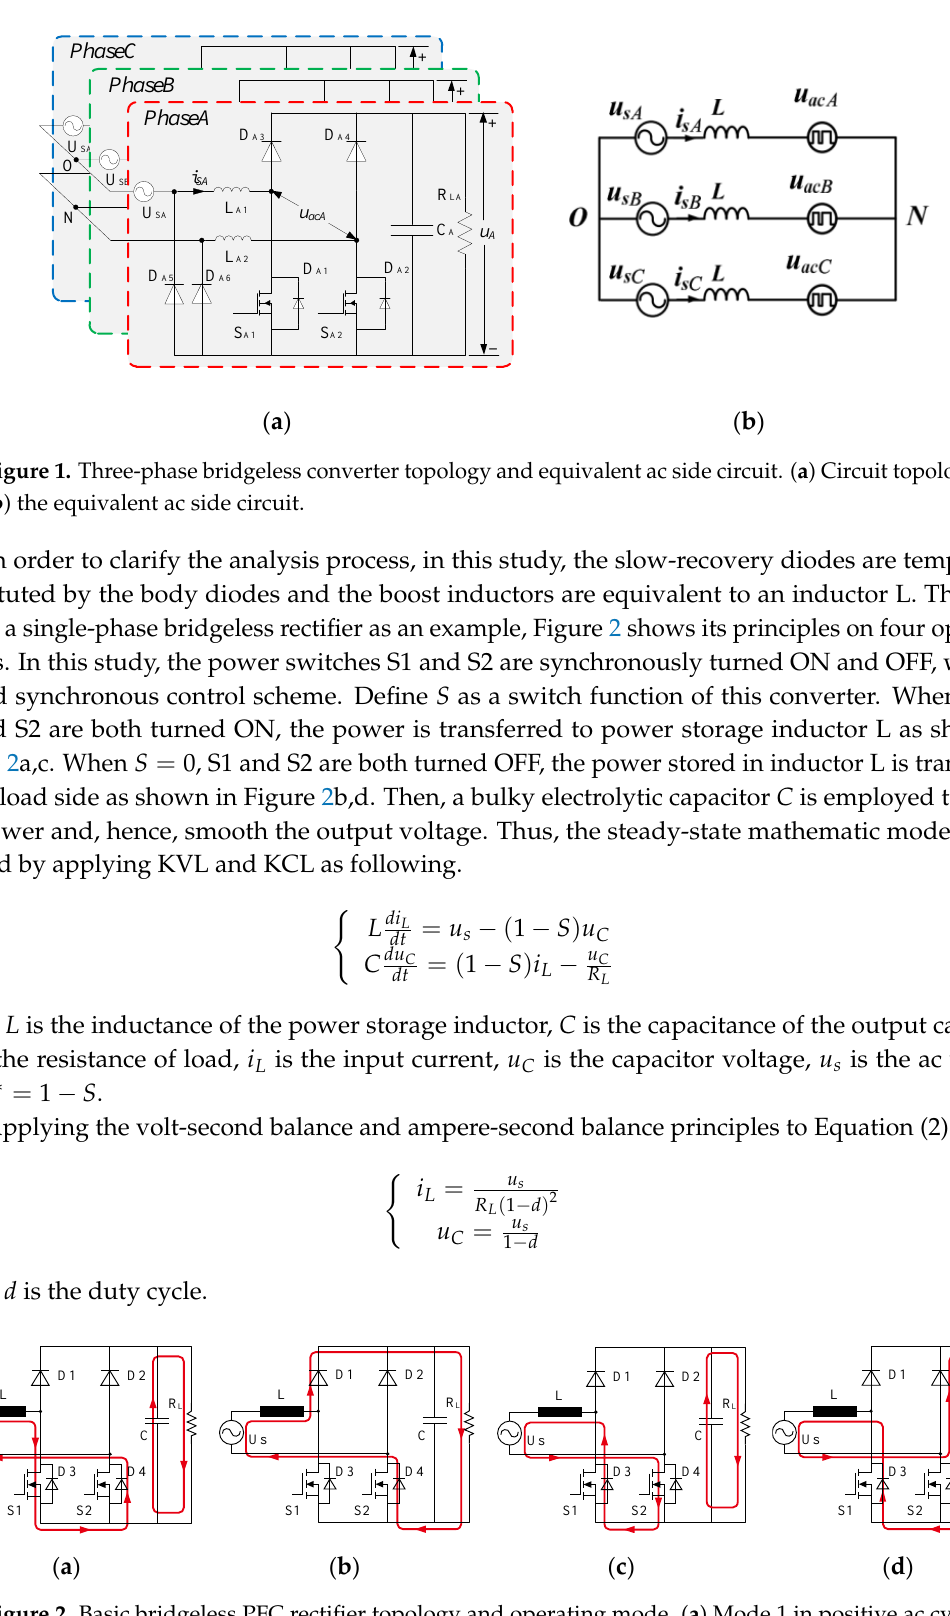
Figure 2. Basic bridgeless PFC rectifier topology and operating mode. ( a ) Mode 1 in positive ac cycle; ( b ) Mode 2 in positive ac cycle l; ( c ) Mode 3 in negative ac cycle; ( d ) Mode 4 in negative ac cycle.